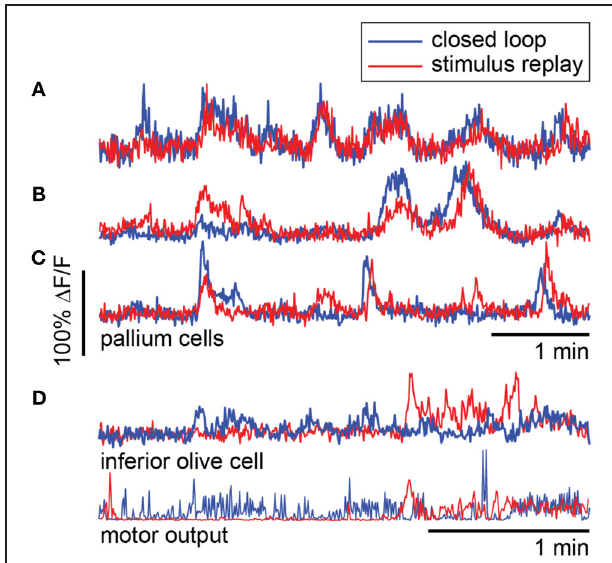
FIGURE 8 | Forebrain activity during closed- and open-loop navigation in a dark-modulated environment is largely stimulus-locked. (A–C) Recordings from pallial neurons during two-dimensional darkness avoidance. For 5min, fish navigated a virtual environment. Next, the stimulus presented during this period was repeated in open-loop. Neural activity during the first 5min shown in blue; activity during the five minutes of stimulus replay shown in red. Neurons a–c are in the same fish, over the same period. (A) Activity in this neuron is identical during the closed- and open-loop periods, indicating that this is a visually-driven neuron with activity that is highly predictable from the visual stimulus alone. (B,C) Two neurons that are stimulus-driven, but whose activity is differently modulated during closed-loop and open-loop replay. Differences in activity may represent differences in the state of the brain during closed- and open-loop control. (D) For comparison, a neuron in the inferior olive with activity that is different during closed-loop and open-loop replay. Activity in this neuron correlates with motor output (bottom). Data were obtained using a one-dimensional OMR assay (Ahrens et al., 2012). Swim patterns during closed- and open-loop are qualitatively different, with behavior in closed-loop being more ongoing, and behavior in open-loop characterized by periods of quiescence and periods of vigorous swimming. These patterns are also reflected in the neural